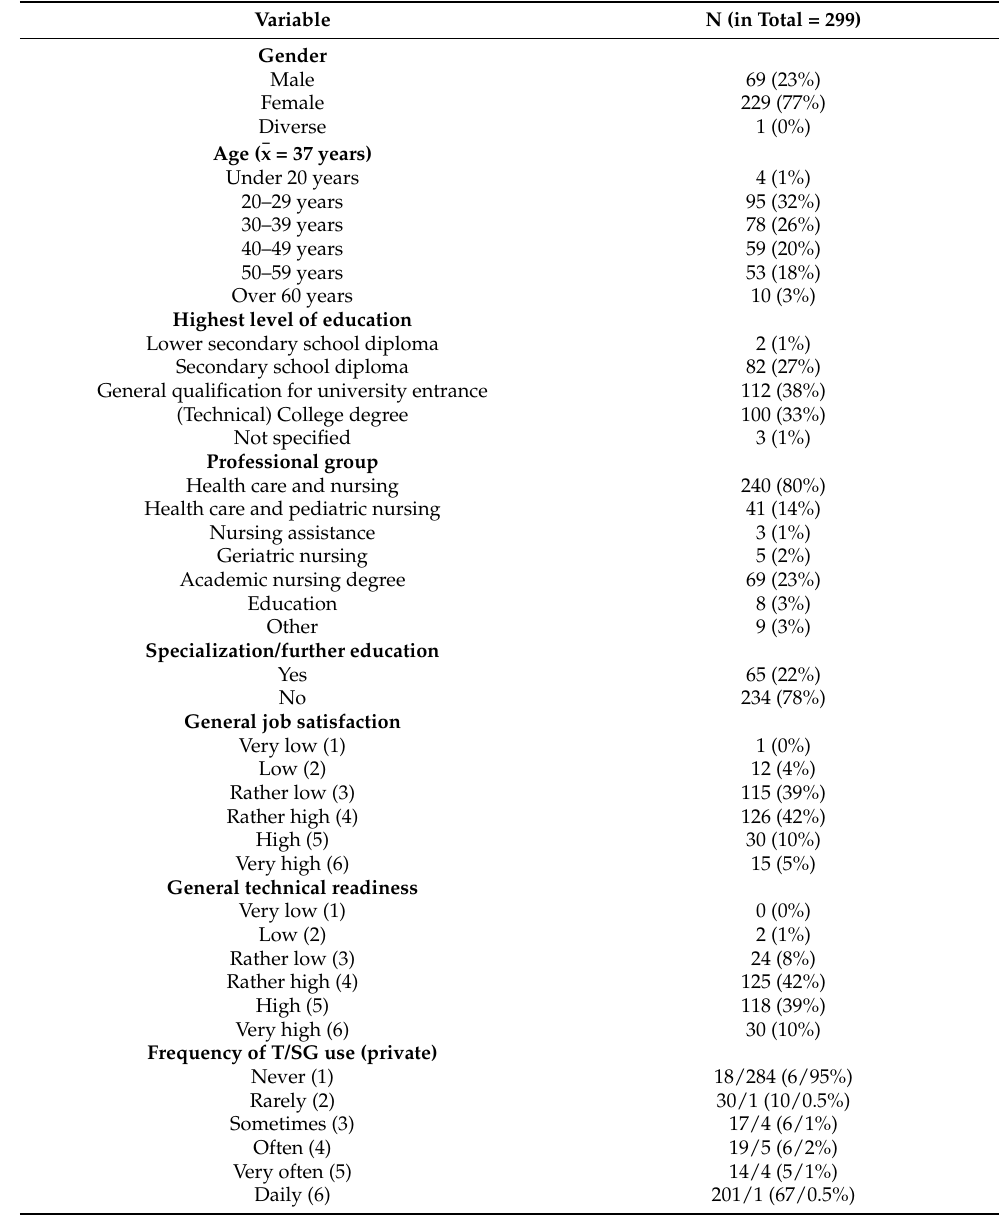
Table 1. Baseline characteristics of